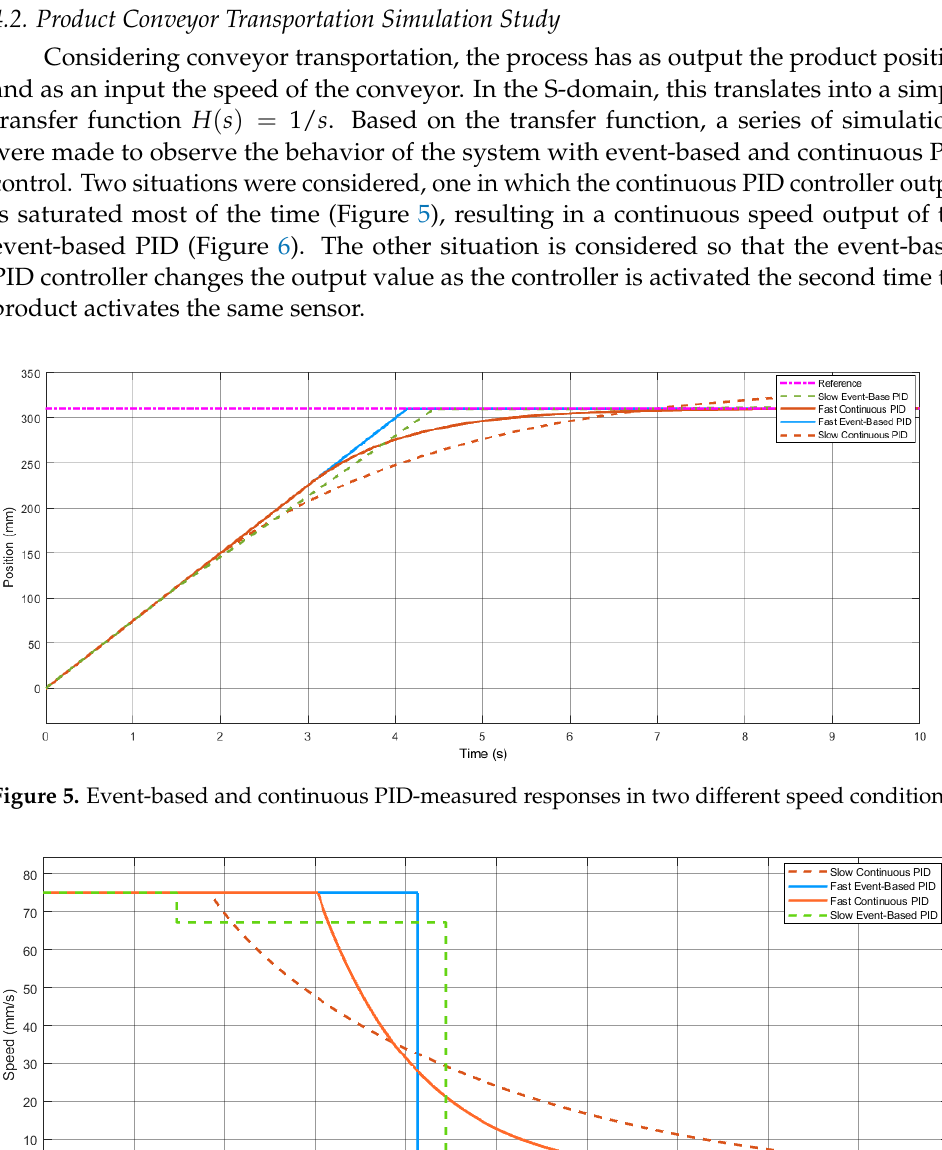
Figure 7. Event-based PID stationary error in the case of reference outside possible discrete points.